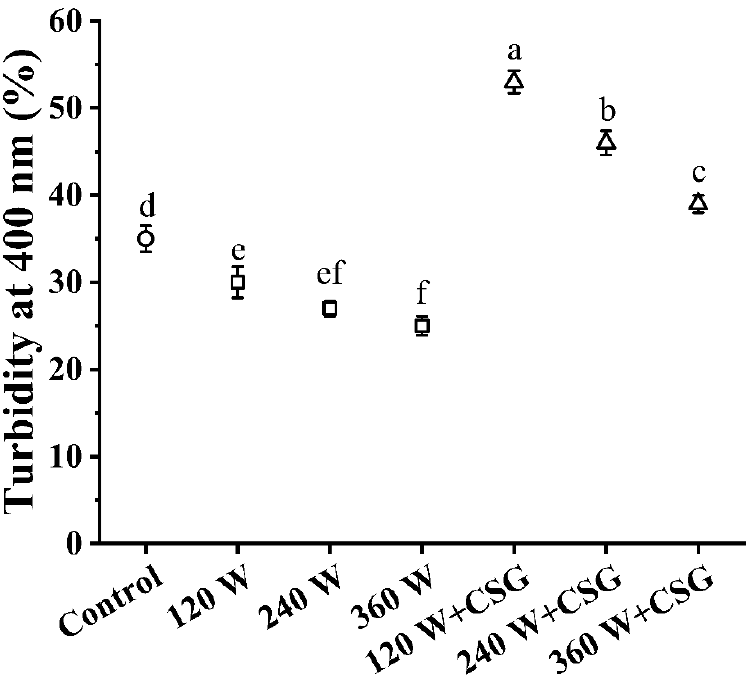
Figure 2. Bulk phase turbidity of WPI and WPI–CSG systems treated by different power ultrasound. Different lowercase letters represent significant differences ( p < 0.05) between data.